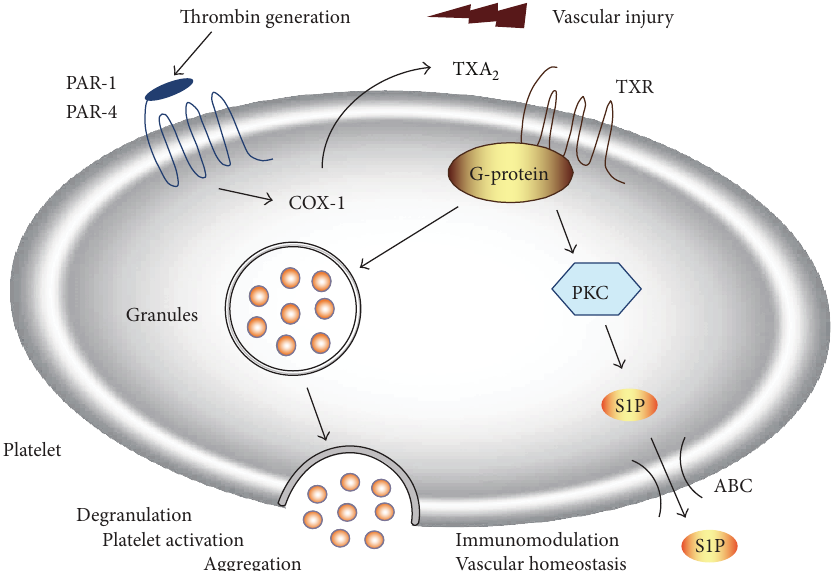
Figure 4: Thrombin-stimulated S1P secretion in human platelets. Thrombin triggers COX-1-mediated synthesis of thromboxane A 2 (TXA 2 ) via activation of platelet PAR-1. Consecutive TX release and activation of thromboxane A 2 receptor (TXR) enhances platelet degranulation and aggregation. In parallel, TXA 2 -TXR signaling stimulates platelet S1P secretion. This pathway involves activation protein kinase C (PKC) and appears to be mediated by an ATP-dependent transport mechanism (ABC, ATP-binding cassette transporter). In a paracrine manner, platelet-derived S1P may modulate endothelial and immune cell responses at sites of